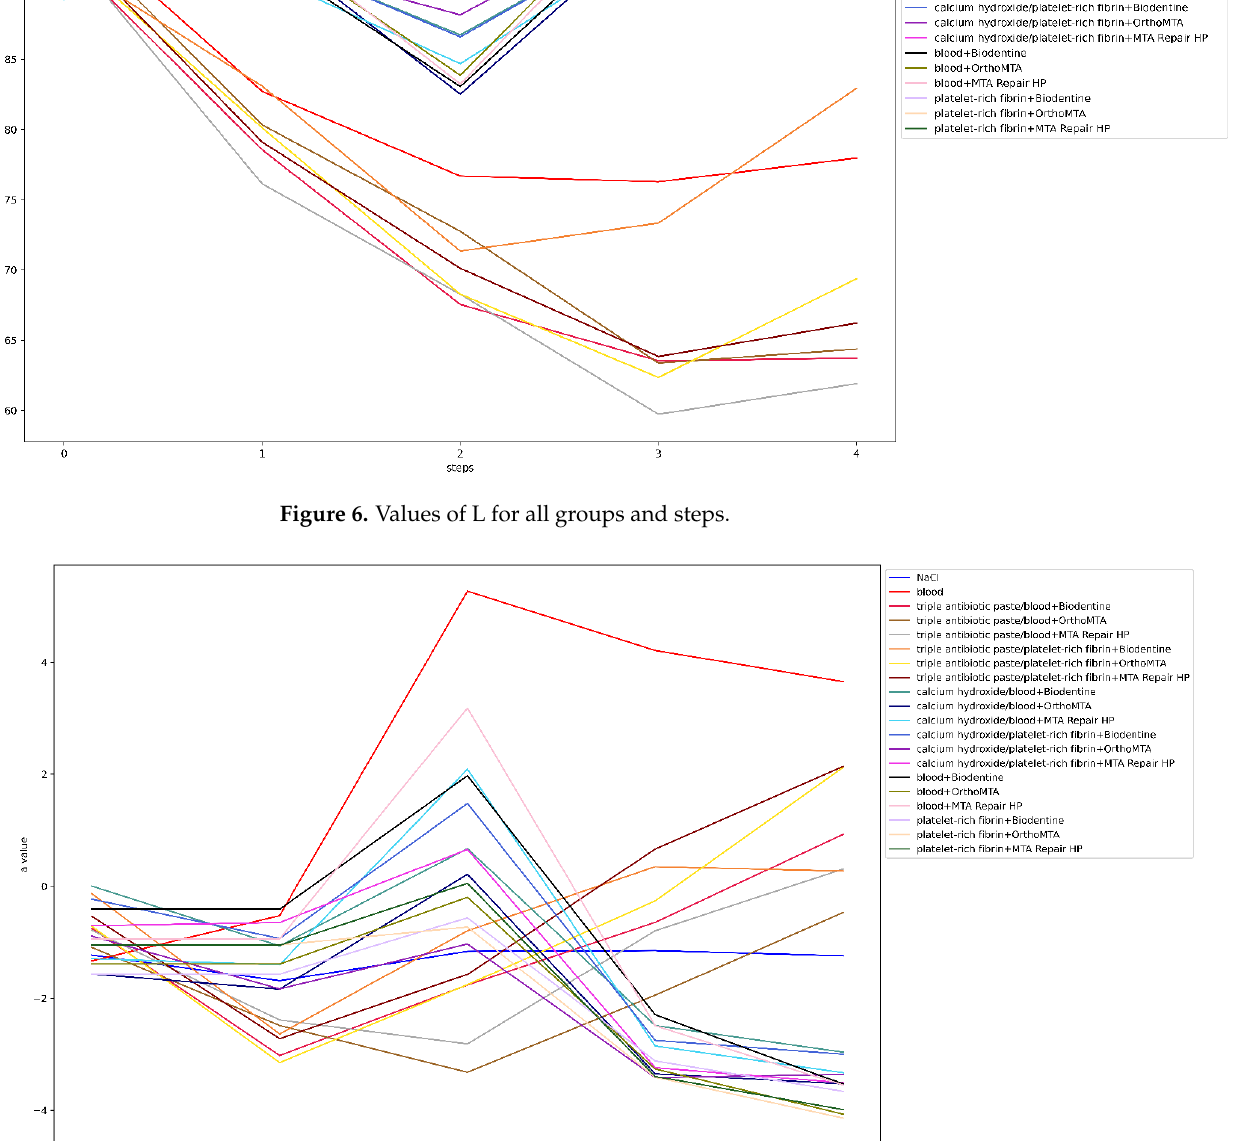
Figure 7. Values of a for all groups and steps .